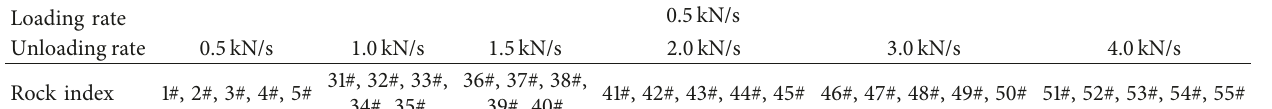
Table 2: Experimental scheme of impacts of uniaxial cyclic unloading rates on rock AE characteristics.